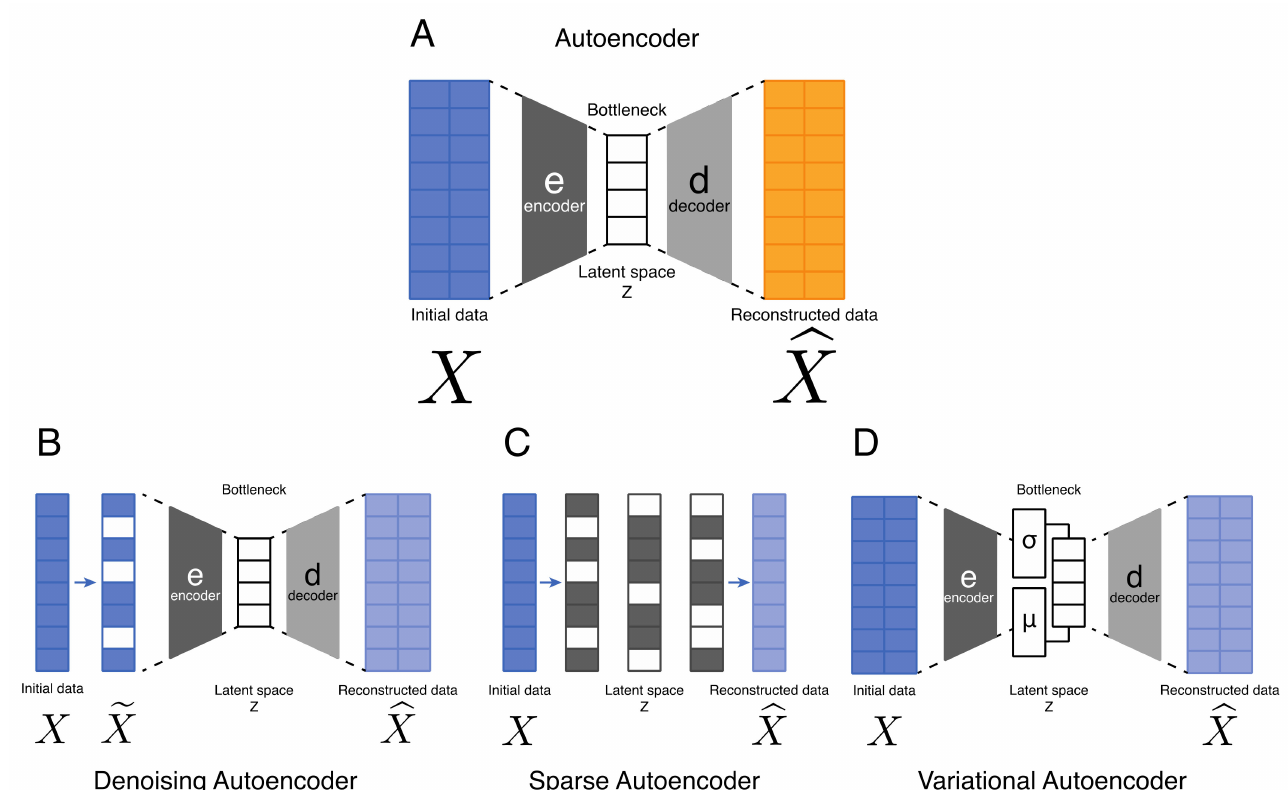
Figure 1. Different types of autoencoder. ( A )—The classical autoencoder (AE) is composed of two main parts. First the encoder, annotated as “e”, encodes the input data through a latent space “Z” by reducing the data dimensionality. The latent space corresponds to a vectorial space with a bottleneck constraint in order to force the algorithm to keep only the most variable features. The second part corresponds to the decoder, annotated as “d”, that reconstructs the input data using the features encoded in the latent space. ( B )—Denoising autoencoders (DAEs) are a category of AE where the input data are corrupted by setting nodes to a value of 0 (indicated in white). ( C )—The sparse autoencoder (SAE) uses a penalty function. By penalizing the use of certain nodes (grey), these nodes are inactivated (white). Thus, the network is forced to learn features without reducing the number of nodes. ( D )–The peculiarity of a variational autoencoder (VAE) is that the algorithm learns a distribution from the latent space “Z”. This distribution is defined by a mean “ µ ” and a standard deviation “ σ